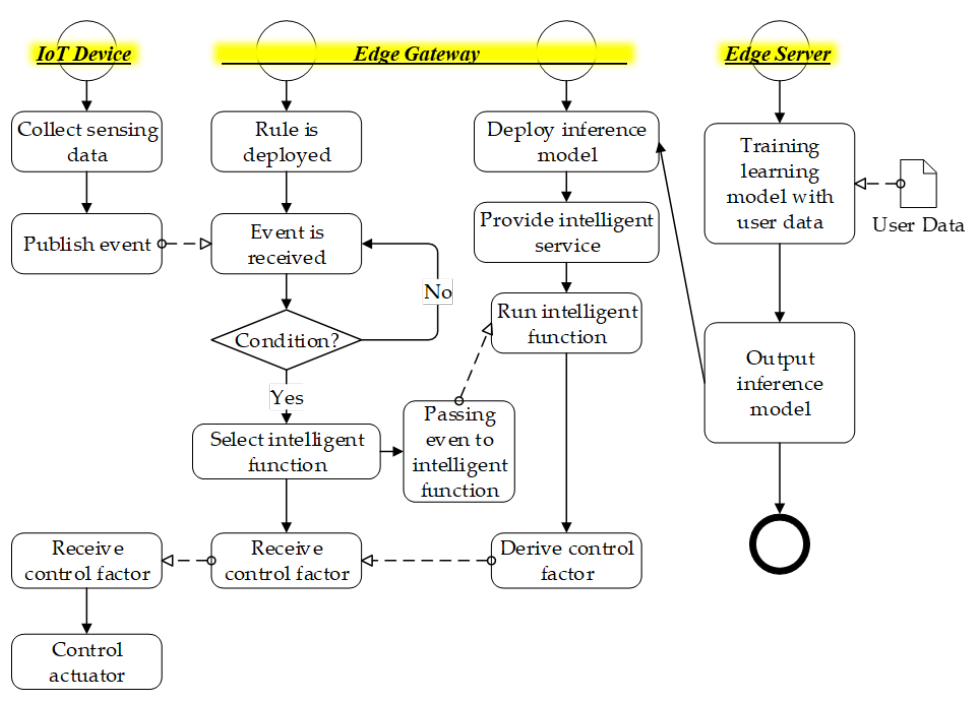
Figure 4. Deployment flow of embedding inference model to rule-based edge gateway.